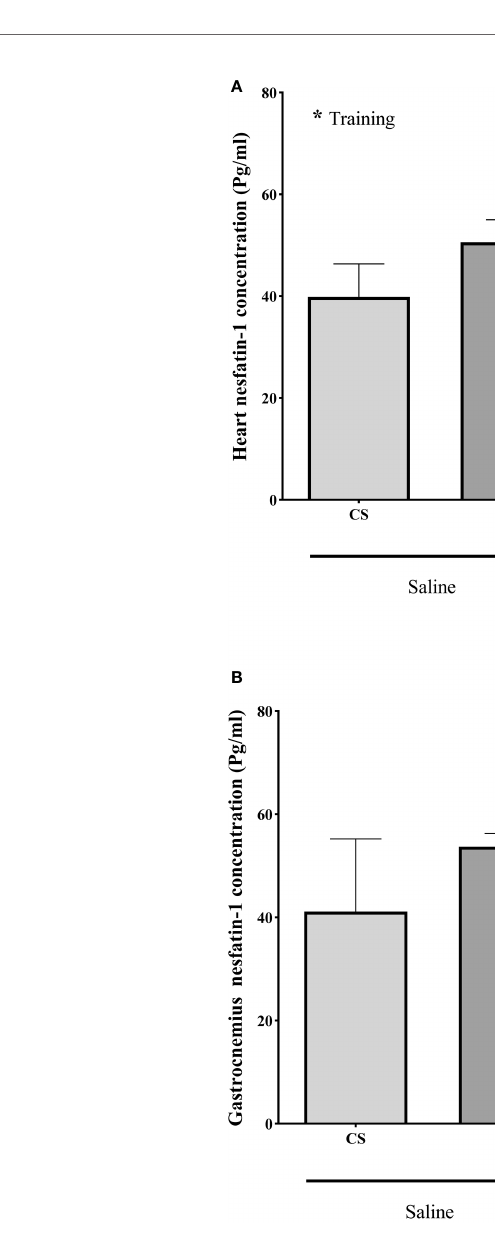
FIGURE 3 | Heart (A) and gastrocnemius (B) muscles nesfatin-1 concentrations (Pg/mg) in Saline-Control (SC), Saline-High Intensity Training (ST), Ziziphus jujuba - Control (ZJC), and Ziziphus jujuba -High Intensity Training (ZJT) groups. Data were expressed mean ± SD, P value set at < 0.05, and 7 rats per each group. * Training main effect (P=0.005 for heart), ** Ziziphus jujuba main effect (P=0.001 for heart), *** Training and Ziziphus jujuba interaction (P=0.002 and P=0.014 for heart and gastrocnemius respectively), # TS than CS (P=0.001 and P=0.015 for heart and gastrocnemius respectively), ## ZJC than CS (P=0.001 and P=0.043 for heart and gastrocnemius